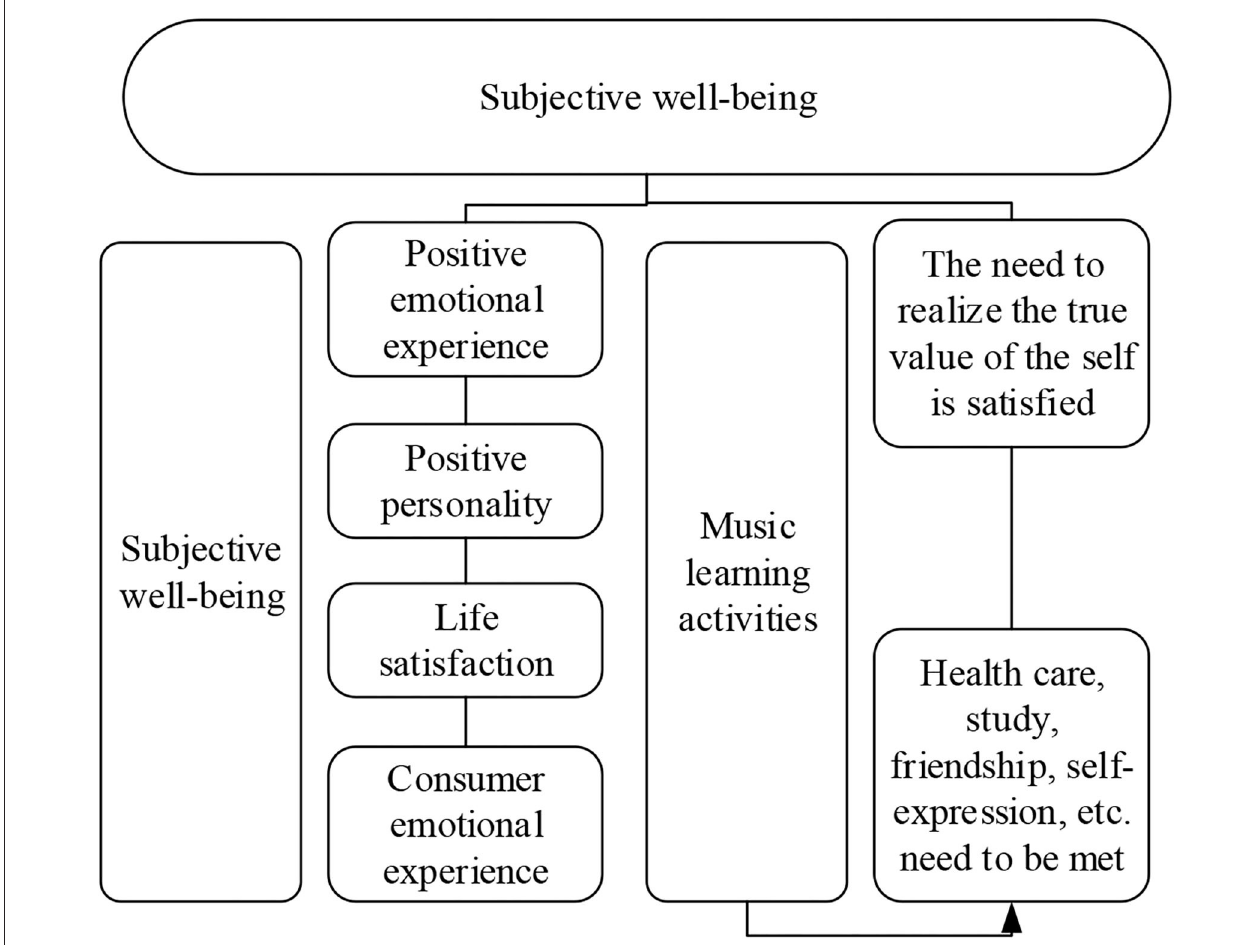
FIGURE 9 | Path of piano learning influencing the positive experience of subjective well-being of the